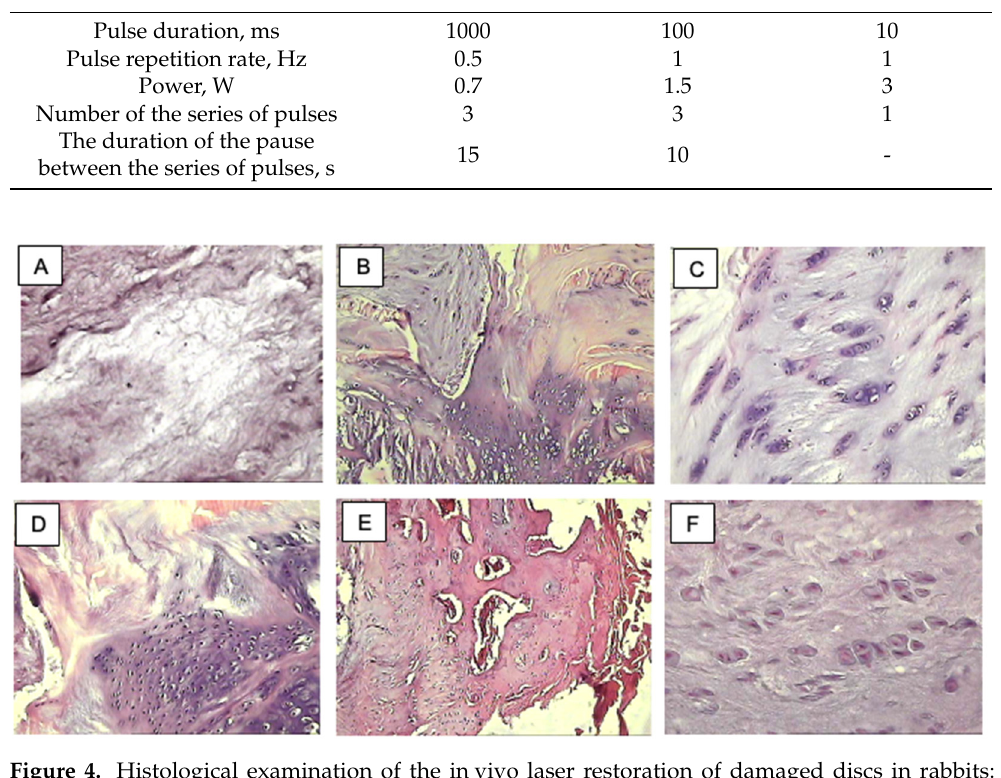
Figure 4. Histological examination of the in vivo laser restoration of damaged discs in rabbits: ( A ) simulation of DDD (control): NP in 2 months after needle insertion. Necrotic acellular tissue, × 400; ( B ) laser-irradiated disc, mode 1. In 30 days in the upper left corner is a fragment of fibrohyaline cartilage in the NP. Area of necrosis (top right) and growing hyaline cartilage tissue (bottom), × 100; ( C ) irradiated disc, mode 1. In 90 days. Transitional fibrohyaline cartilage in the NP. Numerous isogenic groups, fibrosis and hyaline-like (below) matrix, × 200; ( D ) irradiated disc, mode 2. 30 days. Development of hyaline cartilage in two months after laser irradiation, × 400; ( E ) irradiated disc, mode 2. 30 days. Osteophyte, consisting of bone tissue (right), fibro-hyaline cartilage (left), × 200; ( F ) irradiated disc, mode 2. 90 days. Fibrous-hyaline cartilage in the NP, × 400. Hematoxylin and Eosin